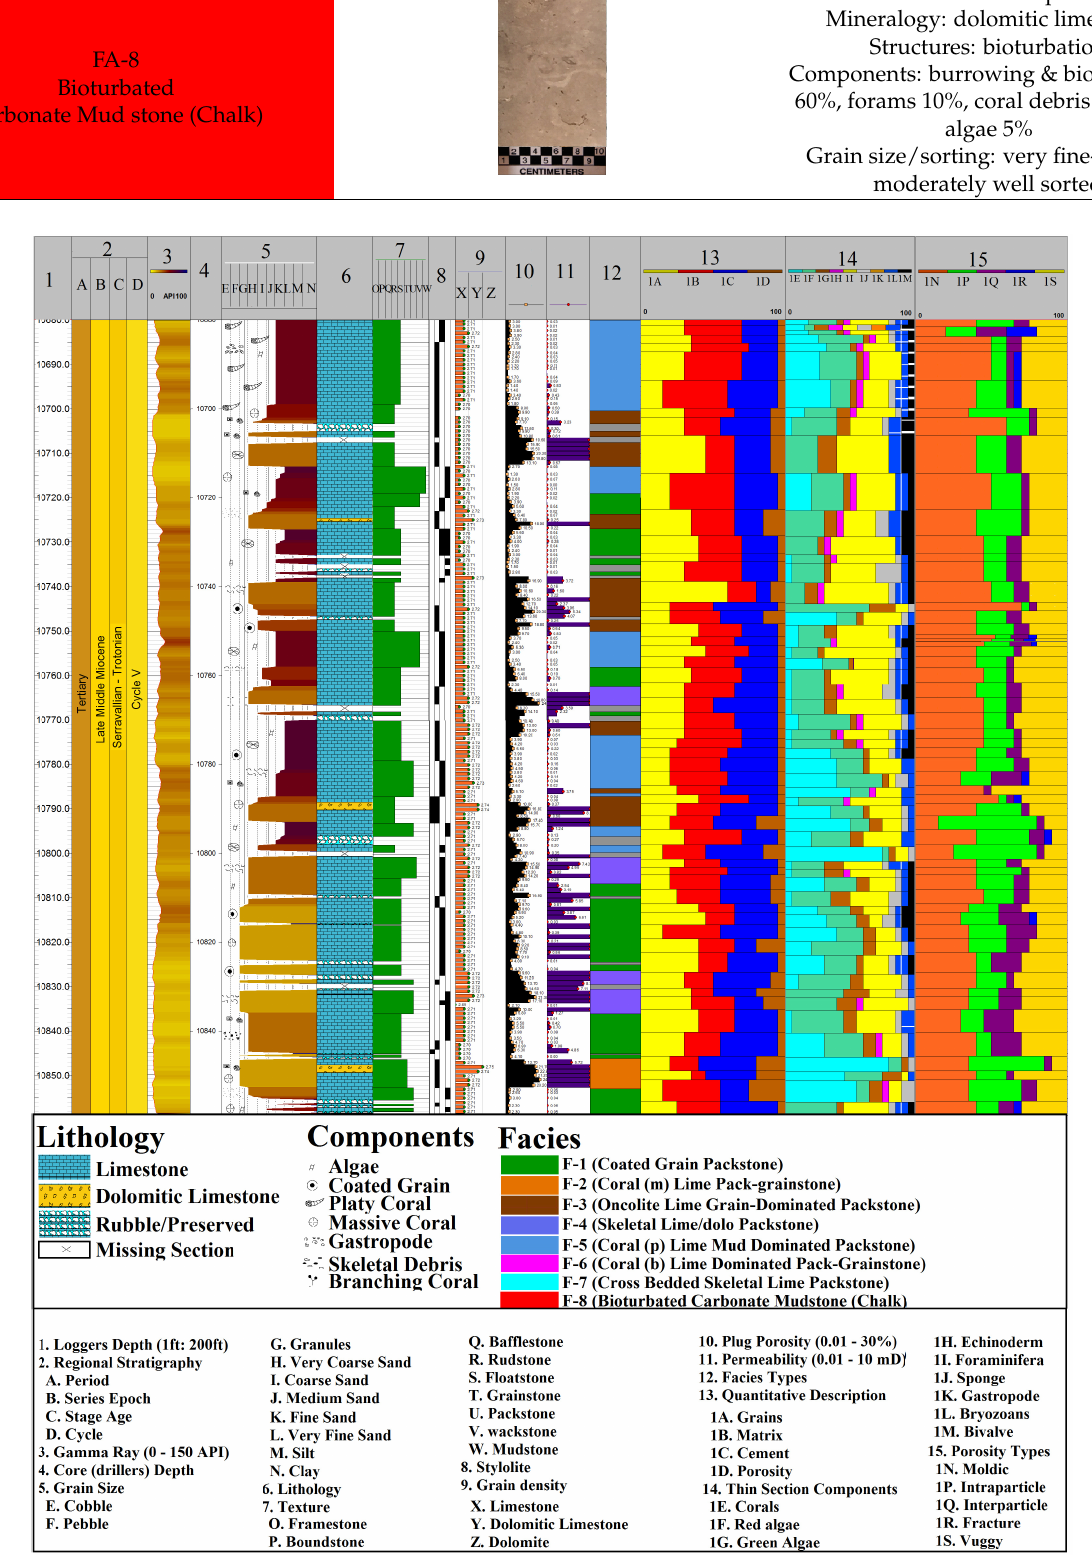
Figure 8. Sedimentological log is showing the qualitative and quantitative description of Well A in Central Luconia, offshore Sarawak,